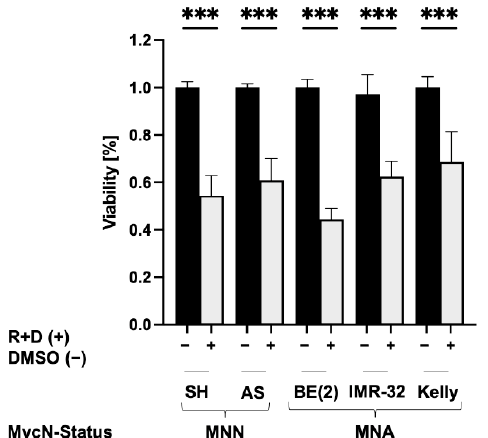
Figure 5. Viability of NB spheroids after R+D ‘pre-treatment’. To determine the impact of the Rapamycin plus Dasatinib (R+D) ‘pre-treatment’ on spheroid viability, spheroids were harvested on day 3 and analyzed applying the CellTiter-Glo 3D Cell Viability Assay. Viability of SK-N-SH (SH), SK-N-AS (AS), SK-N-BE(2) (BE(2)), IMR-32 and Kelly spheroids determined 3 days after treatment with R+D (+) or vehicle ( − ) DMSO treatment. MycN-non-amplified (MNN), MycN-amplified (MNA). Two independent experiments (n = 2) in triplicate were performed. Degrees of significance (unpaired student’s t-test): *** < 0.001.